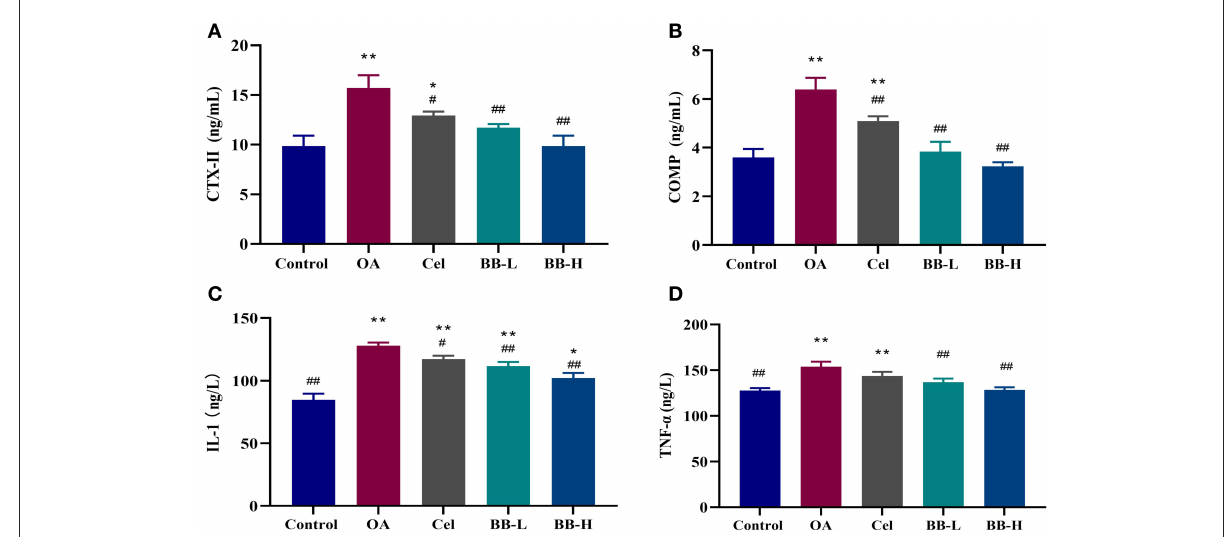
FIGURE7 Following the administration of bilobalide for 8 weeks, the sera of rabbits in each group were tested by ELISA to measure the expressions of (A) CTX-II, (B) COMP, (C) IL-1, and (D) TNF- α . All data are presented as mean ± SD ( n = 3). * p < 0.05 and ** p < 0.01 vs. control group; # p < 0.05 and ## p < 0.01 vs. OA